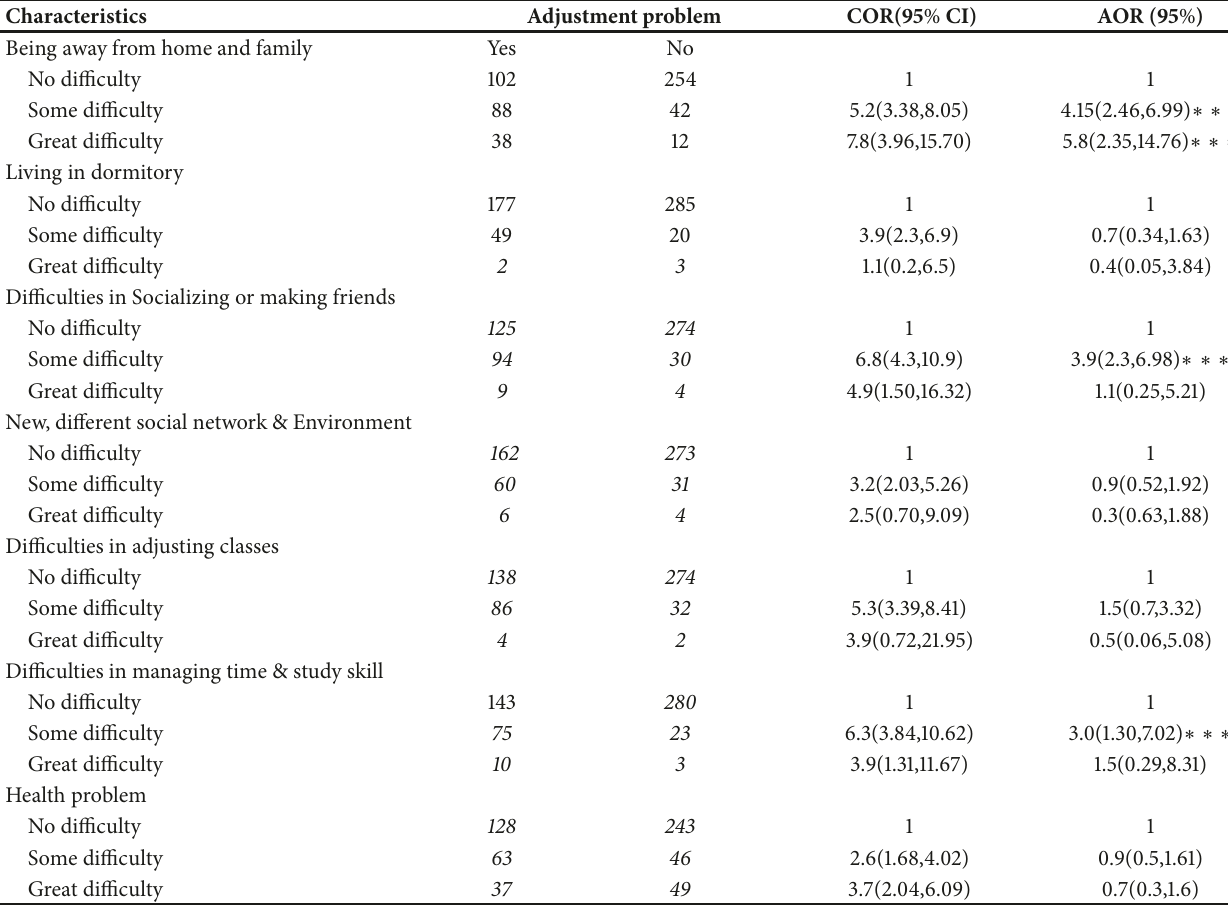
Table 2: Factors associated with adjustment problem among first-year students at Dilla University, Dilla, southern Ethiopia, 2016(N=537). Characteristics